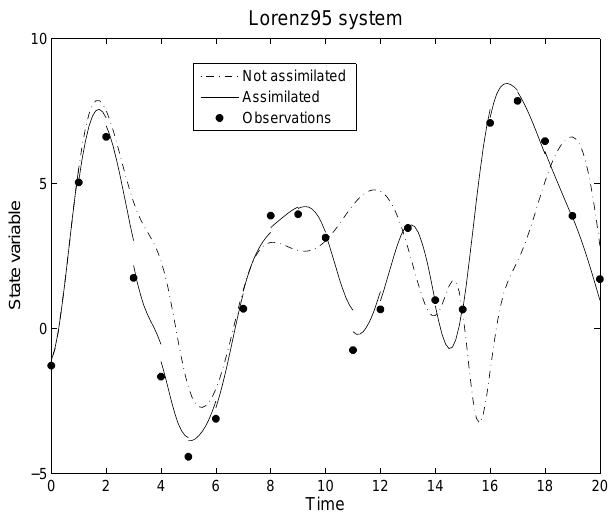
Fig. 1. An illustration of sequential data assimilation in a chaotic system. After some time the control run, even with optimal param- eter values, gets “off track” due to chaos. Data assimilation keeps the model in the same trajectory with the